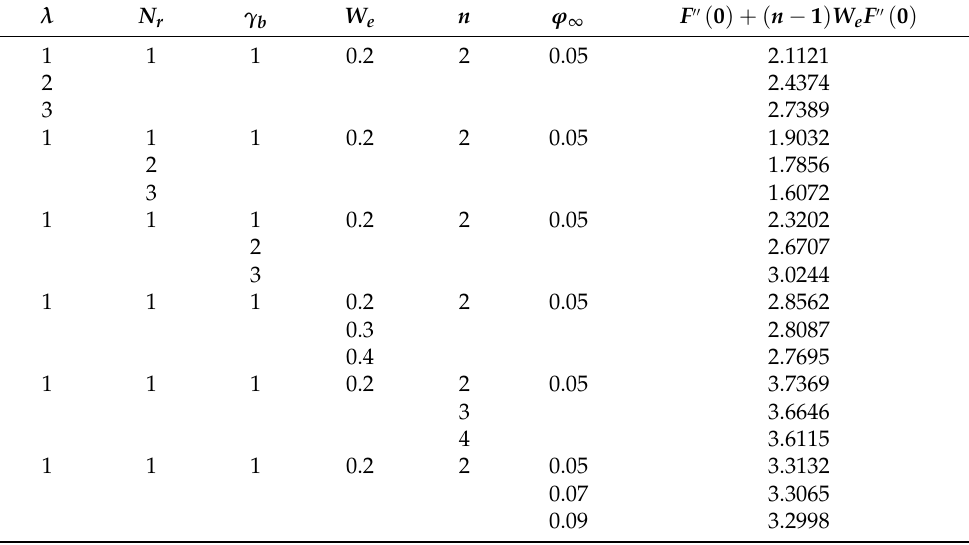
Table 2. The impact of distinct characteristics on the coefficient of skin